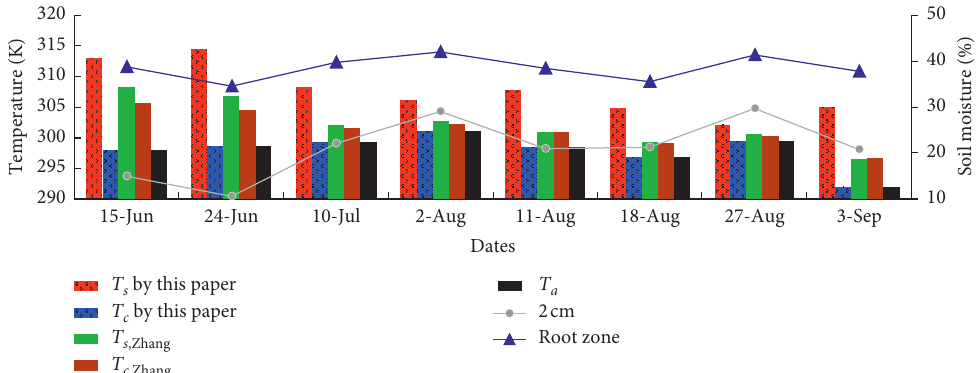
Figure 11: Estimated T c and T s from the soil wetness isoline and the two-stage ET with observed two-layer soil moisture at the DM station; the soil moisture in the root zone is the average of 20, 40, and 80cm based on the research of Wu et al. [72].